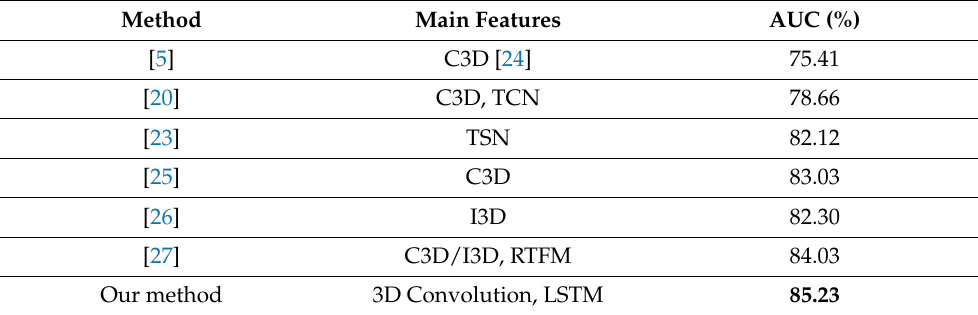
Figure 4. Performance on the two large-scale datasets: ( a ) The evolution of ROCs during the training for the UCF-Crime dataset (the color of the curve transits from green—early epochs, to red—late epochs); ( b ) the evolution of PRCs during the training for the XD-Violence dataset (the color of the curve transits from green—early epochs, to red—late epochs). Table 1. A comparison between the performances of the proposed framework and other state-of-the-art methods on the UCF-Crime dataset (best value found in bold).